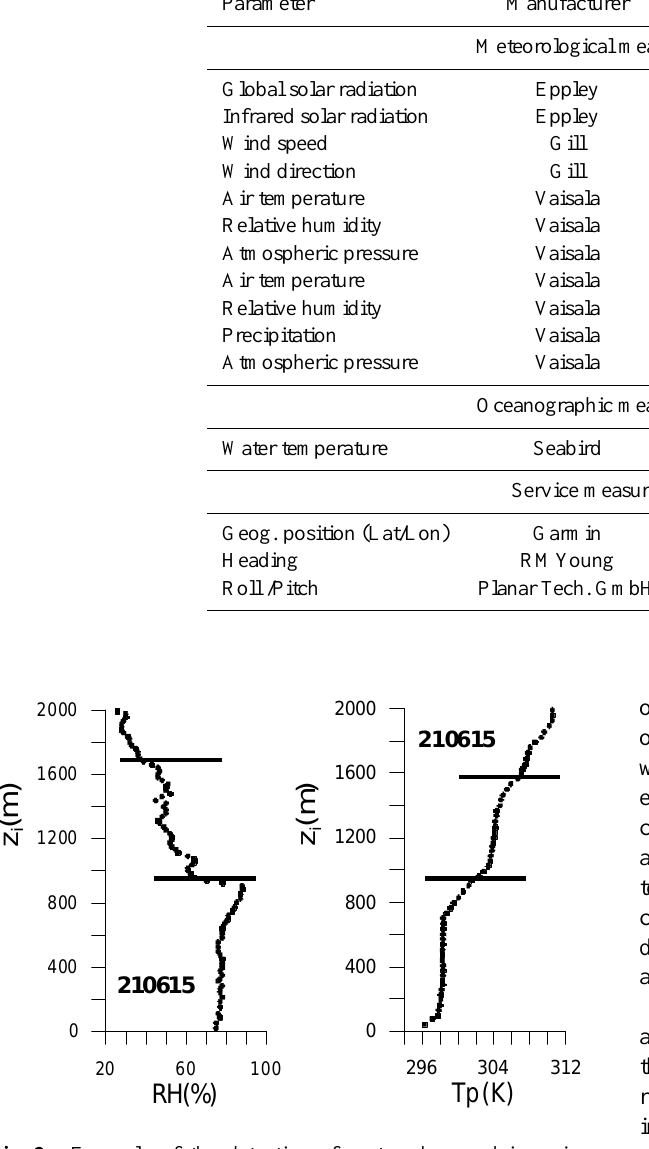
Fig. 2. Example of the detection of first and second inversion heights from radiosonde vertical profiles of Potential Temperature (right) and Relative Humidity (left) during 21 June